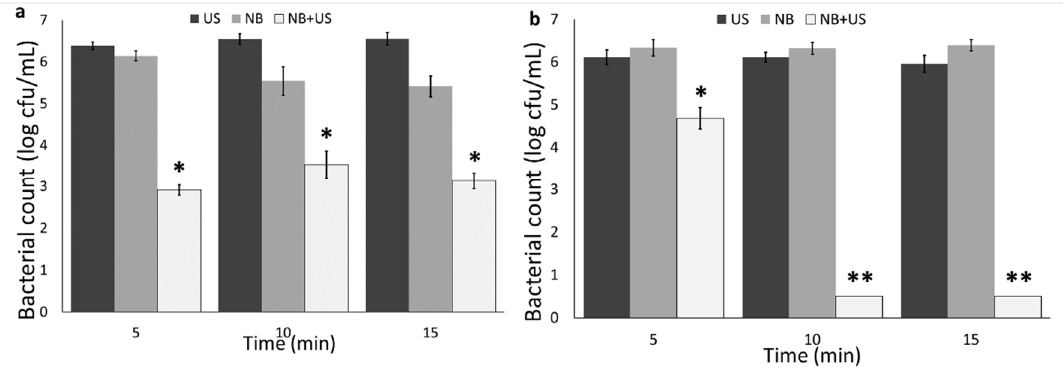
Figure 4. ( a ) V. parahaemolyticus and ( b ) A. hydrophila count in nanobubbles (NB), ultrasound (US), and nanobubbles + ultrasound (NB + US) at different exposure times. Statistical difference was determined based on p < 0.05 (*). Samples with two asterisks (**) were below the limit of detection (0.5 log cfu/mL).